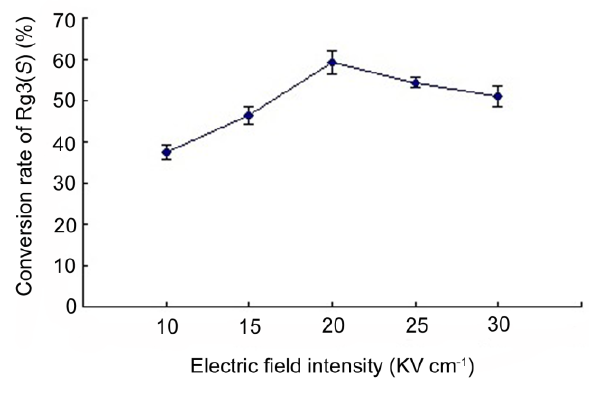
Figure 4: Effect of electric field intensity on the conversion rate of ginsenoside Rg3( S ). Pulse number 8 and acid concentration 0.2 mol/L.